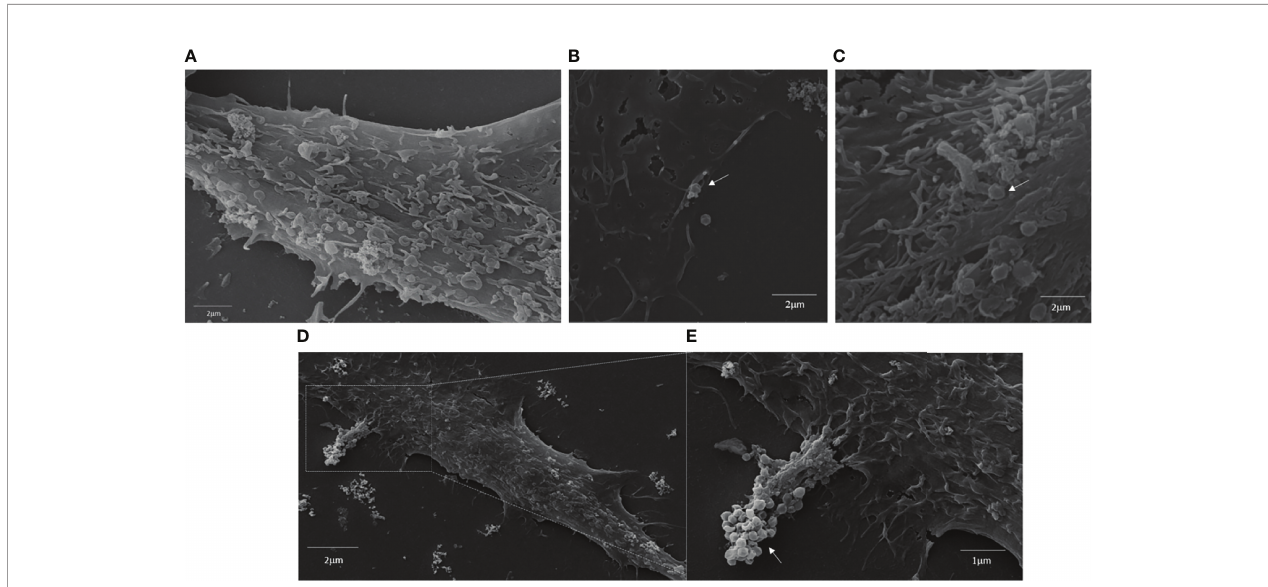
FIGURE 1 | Interaction of APMV, TPV and Mimivirus M4 with A549 cells membranes. A549 cells were incubated with APMV (MOI of 50) TPV (MOI of 50) and Mimivirus M4 for 6 hours at 370C. The samples were then prepared for Scanning Microscopy (see Scanning electron microscopy (SEM) section of materials and methods). (A) Cell in DMEM, Scale bar: 2 µm, (B) Cells incubated with APMV (MOI 50), Scale bar: 2 µm, (C) Cells incubated with TPV (MOI 50), Scale bar: 2 µm and (D, E) , Cells incubated with Mimivirus M4 (MOI 50), Scale bar: 2 µm and 1µm. White arrows signal the presence of